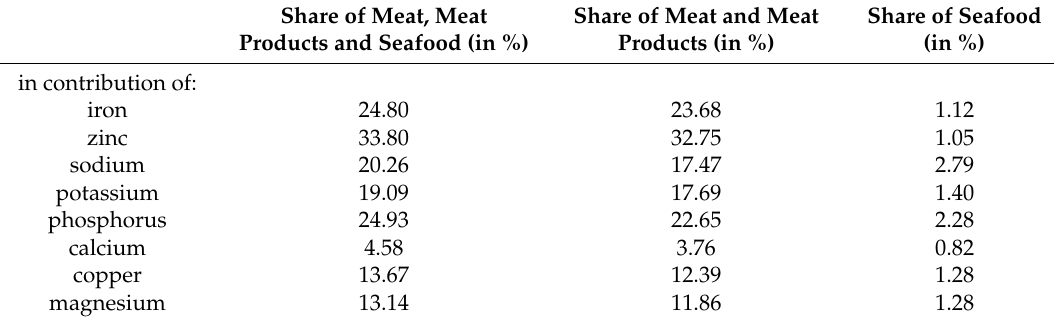
phosphorus, calcium, copper and magnesium in the average Polish diet. Share of Meat, Meat Share of Meat and Products and Seafood (in %)